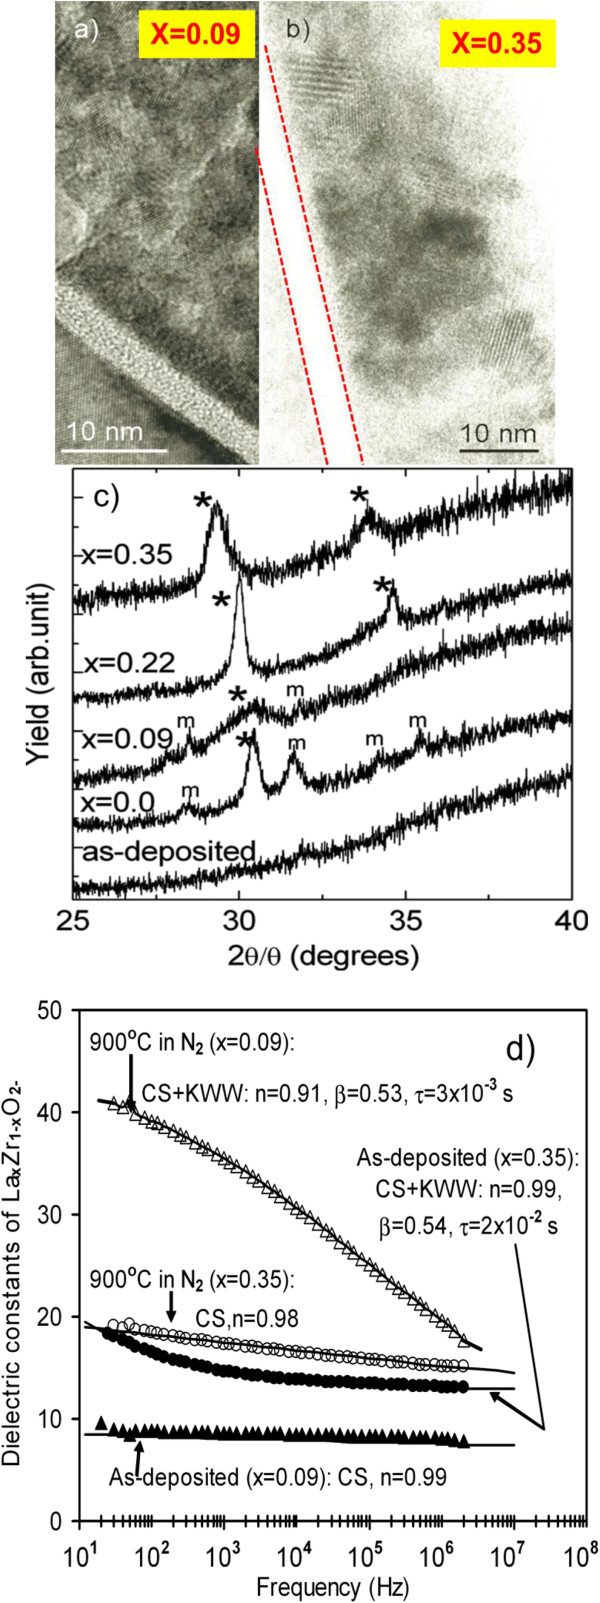
XTEM (a,b), XRD (c), and k-fdata (d) of annealed and as-deposited samples. (a) XTEM of annealed La0.09Zr0.91O2 sample. (b) XTEM of annealed La0.35Zr0.65O2 sample. (c) XRD of as-deposited LaxZr1−xO2−δ. (d) k-f data of as-deposited and annealed LaxZr1−xO2−δ[52].